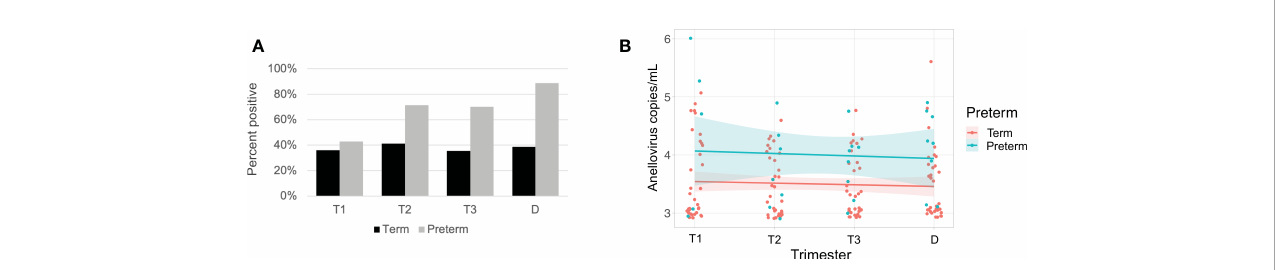
FIGURE 7 Anellovirus positivity and load are higher in subjects that deliver preterm compared with subjects that deliver at term. In (A) , the percentage of maternal samples positive by PCR assay (y-axis) is shown for each time point (x-axis). Results from term subjects are indicated by black bars; preterm subjects are indicated by gray bars. In (B) , only subjects who were positive for anellovirus in at least one of their samples are included. The anellovirus copies per mL (y-axis) is shown for each time point (x-axis), and the fi tted line is plotted with the 95% con fi dence interval shaded. Term subjects are plotted in pink, and preterm subjects are in blue. Term and preterm groups differed by both positivity (P<0.01) and viral load (P=0.003) by generalized linear mixed effects model. T1, Trimester 1; T2, Trimester 2; T3, Trimester 3; D,